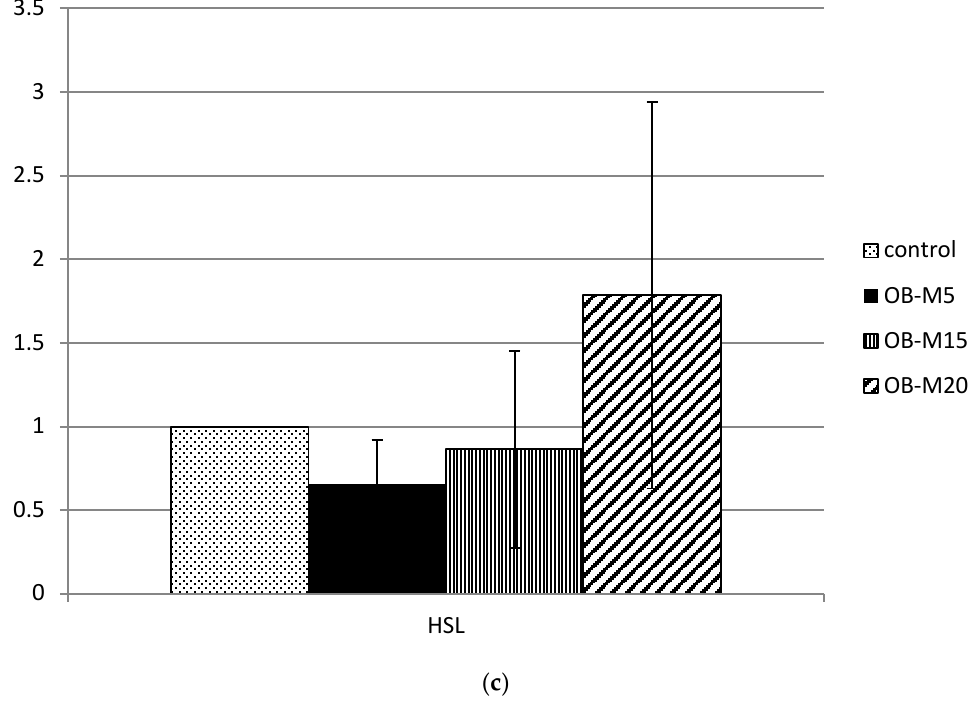
Figure 3. Real-time quantitative PCR analysis of peroxisome proliferator activator receptor (PPAR)γ, lipoprotein lipase (LPL), and hormone-sensitive lipase (HSL) mRNA levels in epididymal white adipose tissues of hamsters with diet-induced obesity fed the experimental oil for eight weeks. Values are presented as the mean ± SEM ( n = 7). PPARγ mRNA levels were normalized to glyceraldehyde-3-phosphate dehydrogenase (GAPDH) mRNA levels. LPL and HSL mRNA levels were normalized to β-actin mRNA levels. The graph represents mRNA levels of PPARγ ( a ); LPL ( b ); and HSL ( c ) relative to the control group. Control, 5% w / w soybean oil; OB-M 5 , 5% w / w of experimental oil mix; OB-M 15 , 15% w / w of experimental oil mix; OB-M 20 , 20% w / w experimental oil mix.